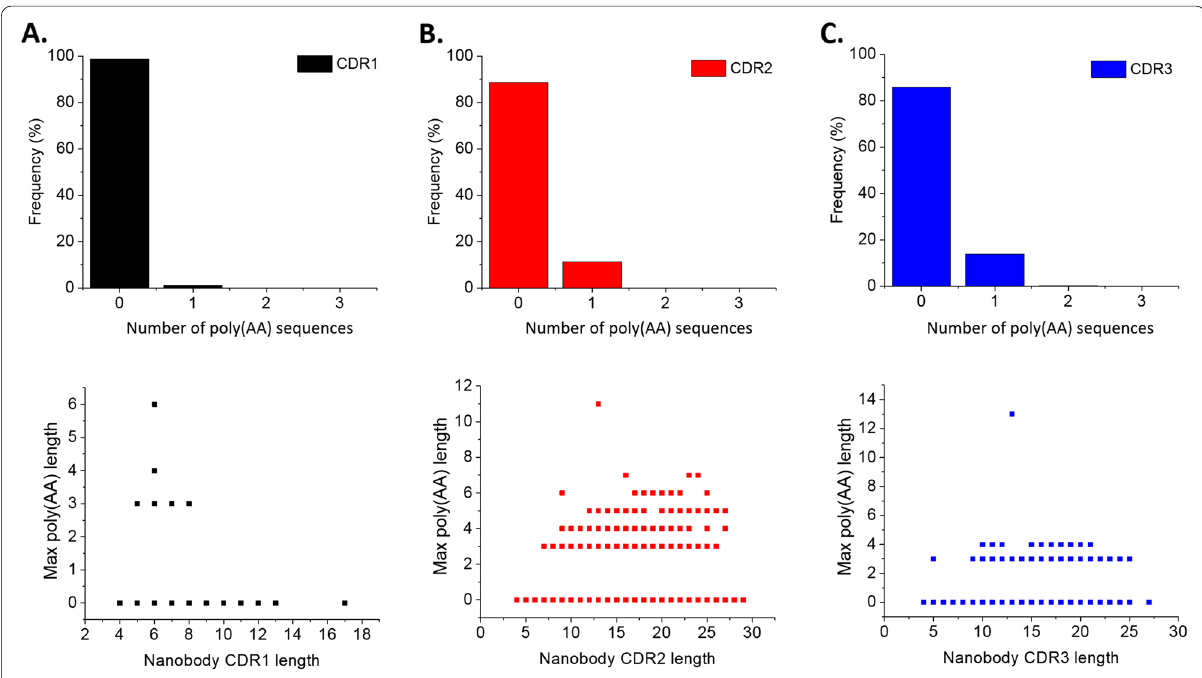
Fig. 5 Distribution of polyamino acids and correlation between their occurrence and CDR length. A CDR1; B CDR2; C CDR3